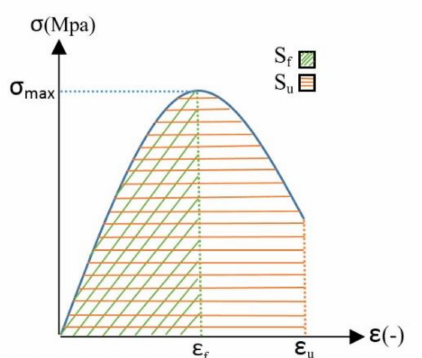
Figure 15. Schematic of stress–strain curve and related relevant